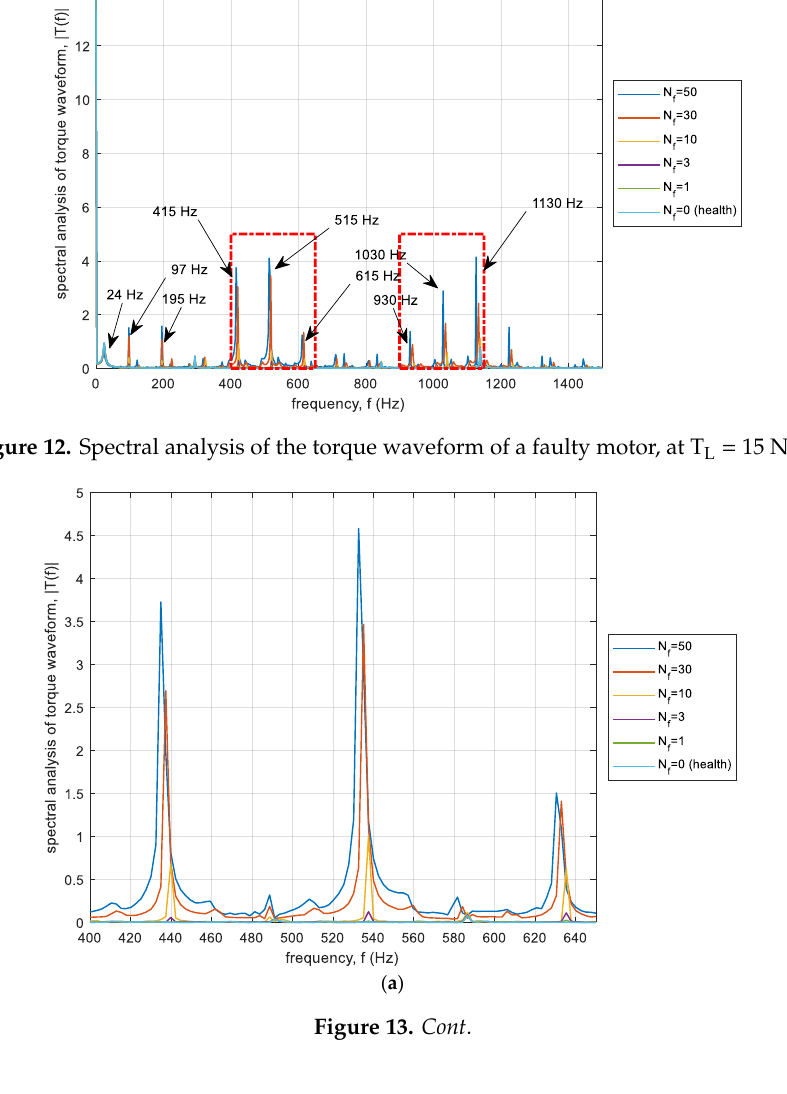
( b ) Figure 13. Spectral analysis of the torque waveform of a faulty motor limited in frequency: ( a ) 400–650 Hz and ( b ) 950–1200 Hz, at T L = 0 Nm.